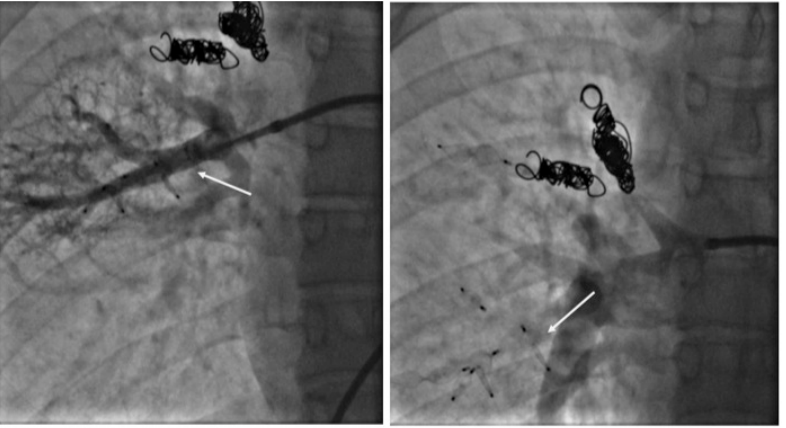
Figure 2: Embolization procedures using the Amplatzer Vascular Plug IV (8 devices) as well as insertion of Amplatzer Vascular Plug IV (2 device) within the systemic-pulmonary bridge.